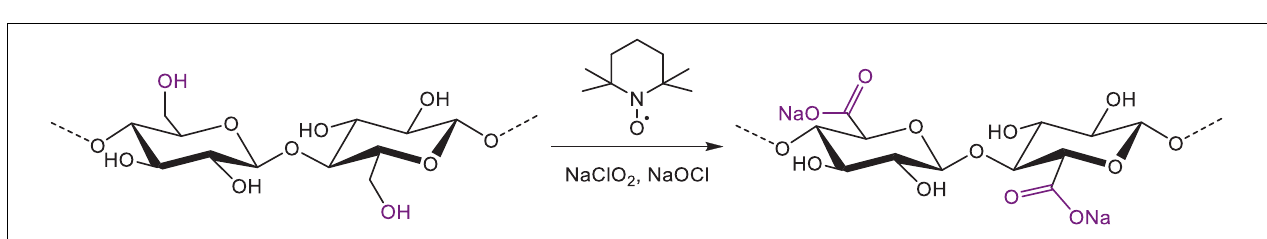
FIGURE 2 | Oxidation of vicinal hydroxyl groups on the β -glucan molecule in the presence of sodium periodate (NaIO 4 ). Note that only β -(1 → 4)-linked units are oxidised.